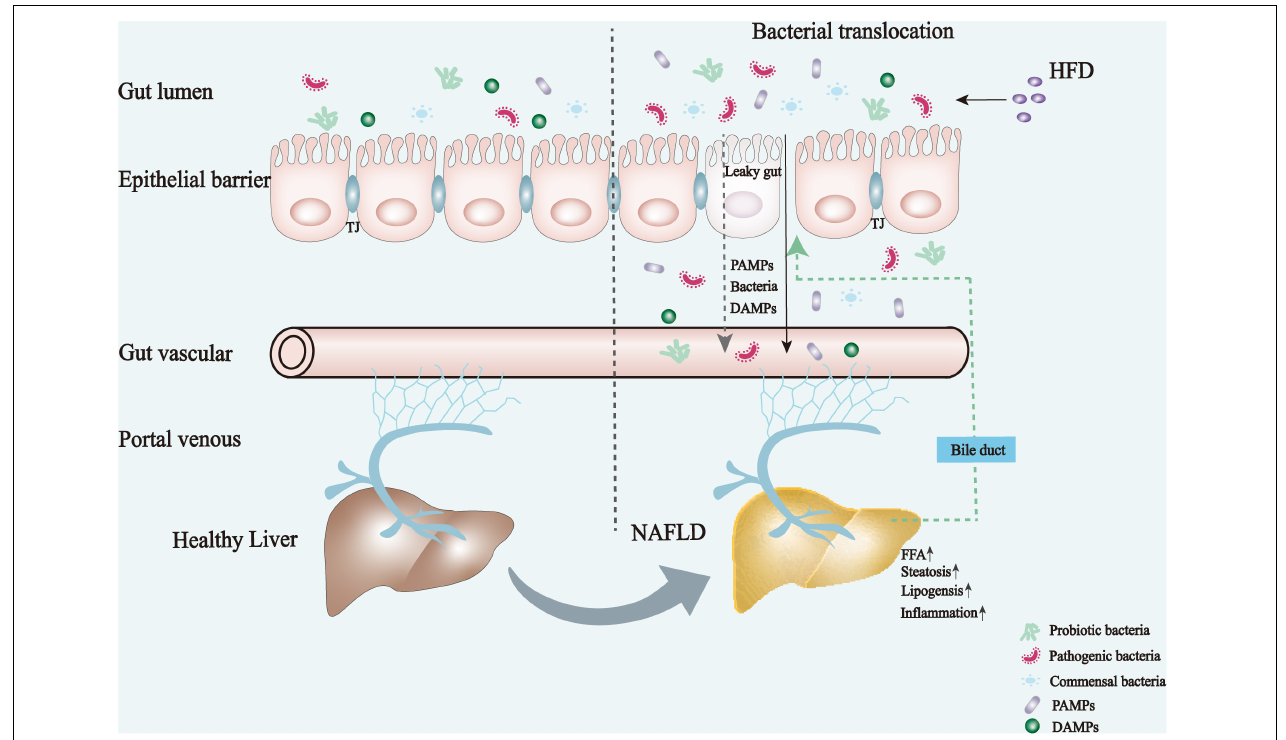
FIGURE 1 | Mechanism underlying the pathogenesis and physiological alterations of NAFLD. High-caloric diets lead to an imbalanced intestinal flora, which in turn elicits an impaired gut barrier function and increased permeability, followed by bacterial translocation and an increase of harmful metabolites or bacterial products that eventually enter the liver through the portal vein. These factors together promote the development of NAFLD by exacerbating hepatic steatosis, lipogenesis, and inflammatory responses. DAMPs, damage-associated molecular patterns; FFA, free fatty acid; HFD, high-fat diet; TJ, tight junctions; PAMPs, pathogen-associated molecular